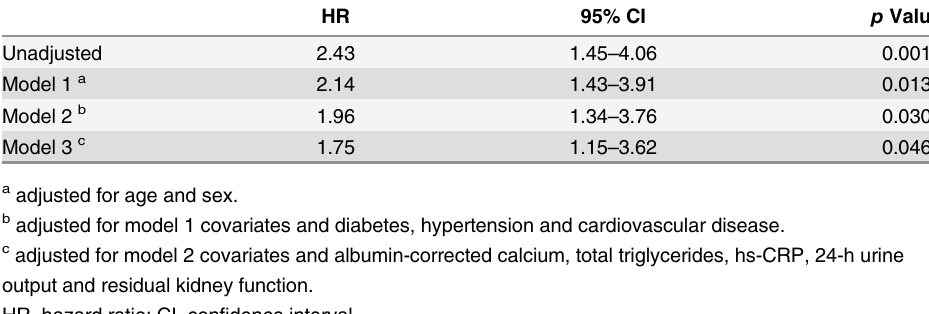
Table 4. Hazard ratio of stroke in hemodialysis versus peritoneal dialysis groups.